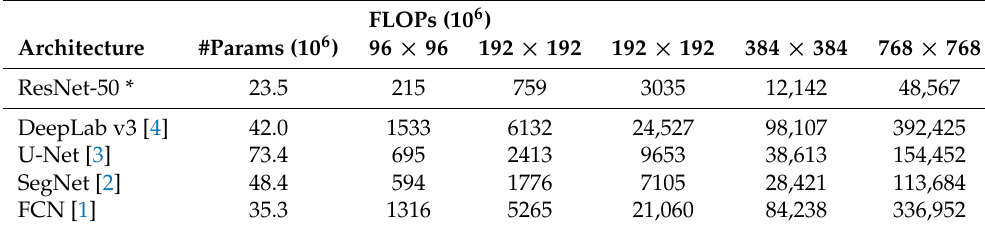
Table 1. Number of parameters and FLOPs per architecture.